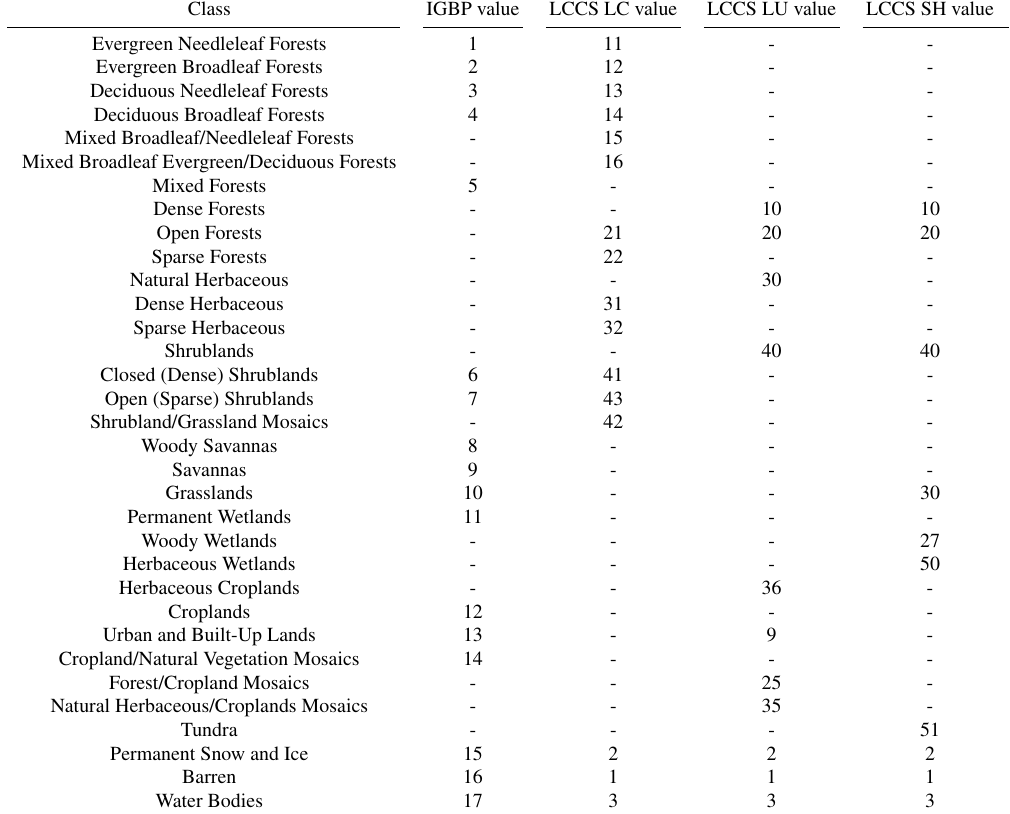
Table 2. MODIS land cover classes as represented by four different schemes: IGBP, LCCS land cover, LCCS land use, LCCS surface hydrology. The NoData value is set to be 255 (Sulla-Menashe and Friedl, 2018). data at a scale of 10 m in the form of GeoTiffs. In this context, it has to be noted that the 10 m scale is defined at the equator by Google Earth Engine, which corresponds to an angular reso- lution of 0 . 0001 ◦ . This angular resolution leads to significantly smaller pixel widths for regions with latitudes deviating from 0 ◦ .